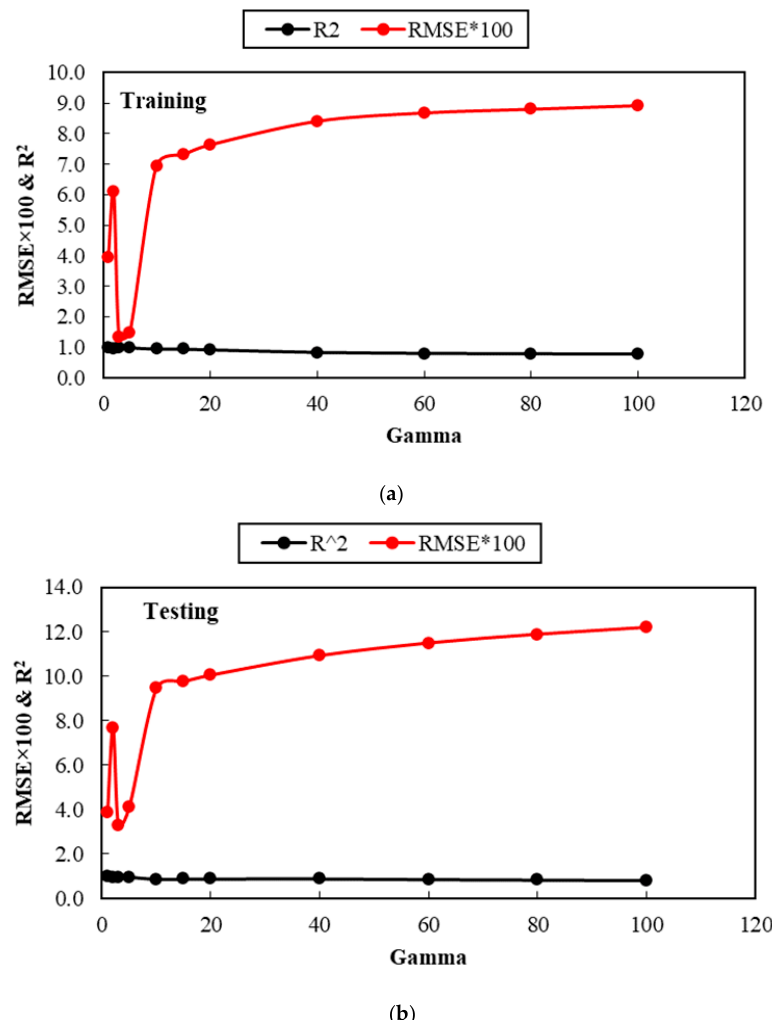
Figure 7. Variation of RMSE and R 2 vs. Gamma ( γ ) values for best model in the second scenario. ( a ) Training; ( b ) testing.